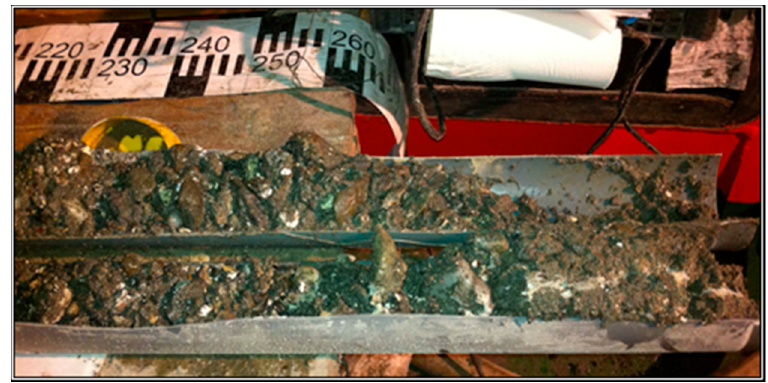
Figure 12. Very coarse gravel in VBC_27 sample.